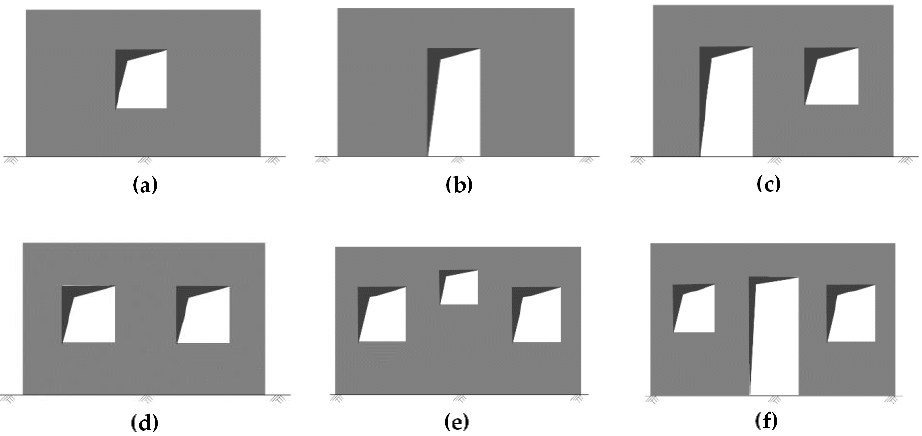
Figure 2. Classification of URM walls according to type and number of openings: ( a ) Type 1, ( b ) Type 2, ( c ) Type 3, ( d ) Type 4, ( e ) Type 5, ( f ) Type 6.